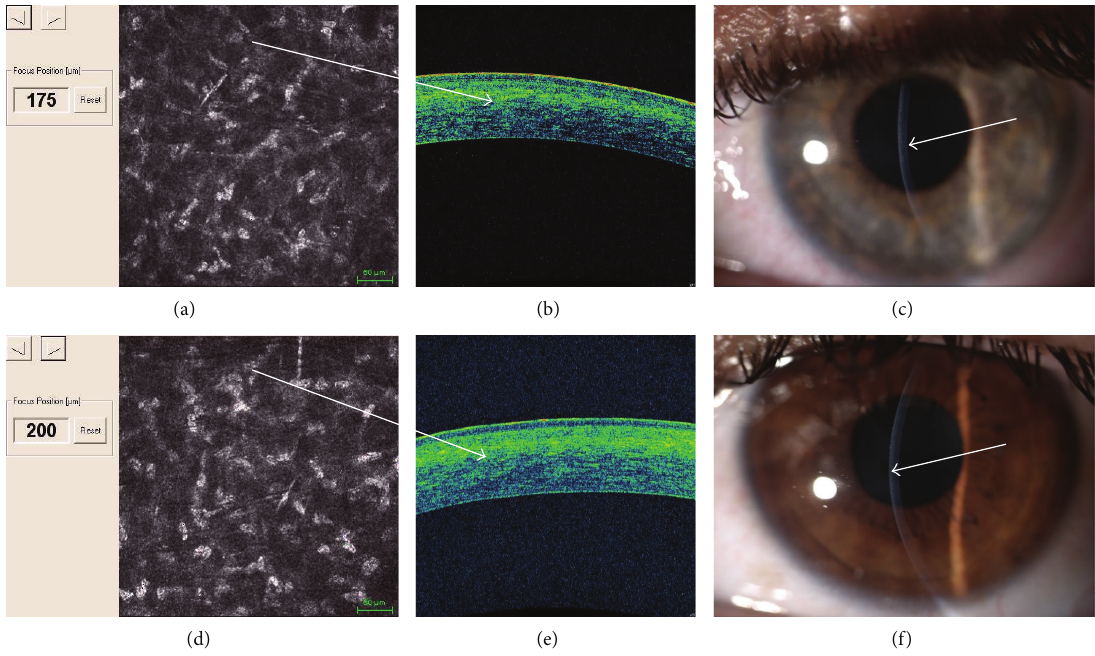
Figure 7: In vivo confocal microscopy (IVCM) after continuous light accelerated crosslinking showed keratocytes apoptosis until 175 𝜇 m (up left (a)), an uneven demarcation line is well detectable with spectral domain corneal OCT showing hyperreflective corneal tissue (up, white arrow (b)); the demarcation line was also visible at slit lamp one month after treatment (up right, white arrow (c)). In vivo confocal microscopy (IVCM) after pulsed light accelerated crosslinking showed keratocytes apoptosis until 200 𝜇 m (down left (a)); a deeper demarcation line is well detectable with spectral domain corneal OCT showing hyperreflective corneal tissue (down, white arrow (b)); the demarcation line was also visible at slit lamp one month after treatment (down right, white arrow